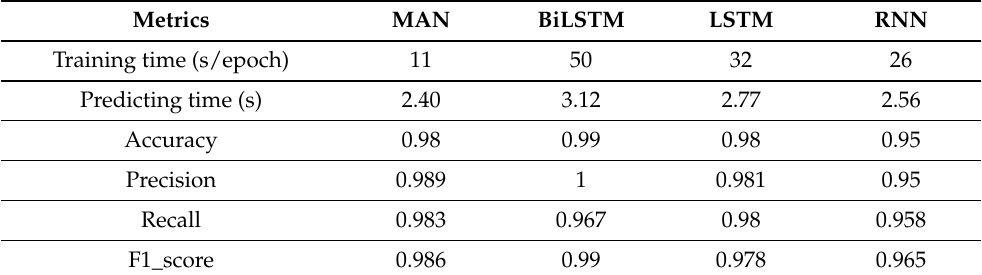
Table 4. Model results and